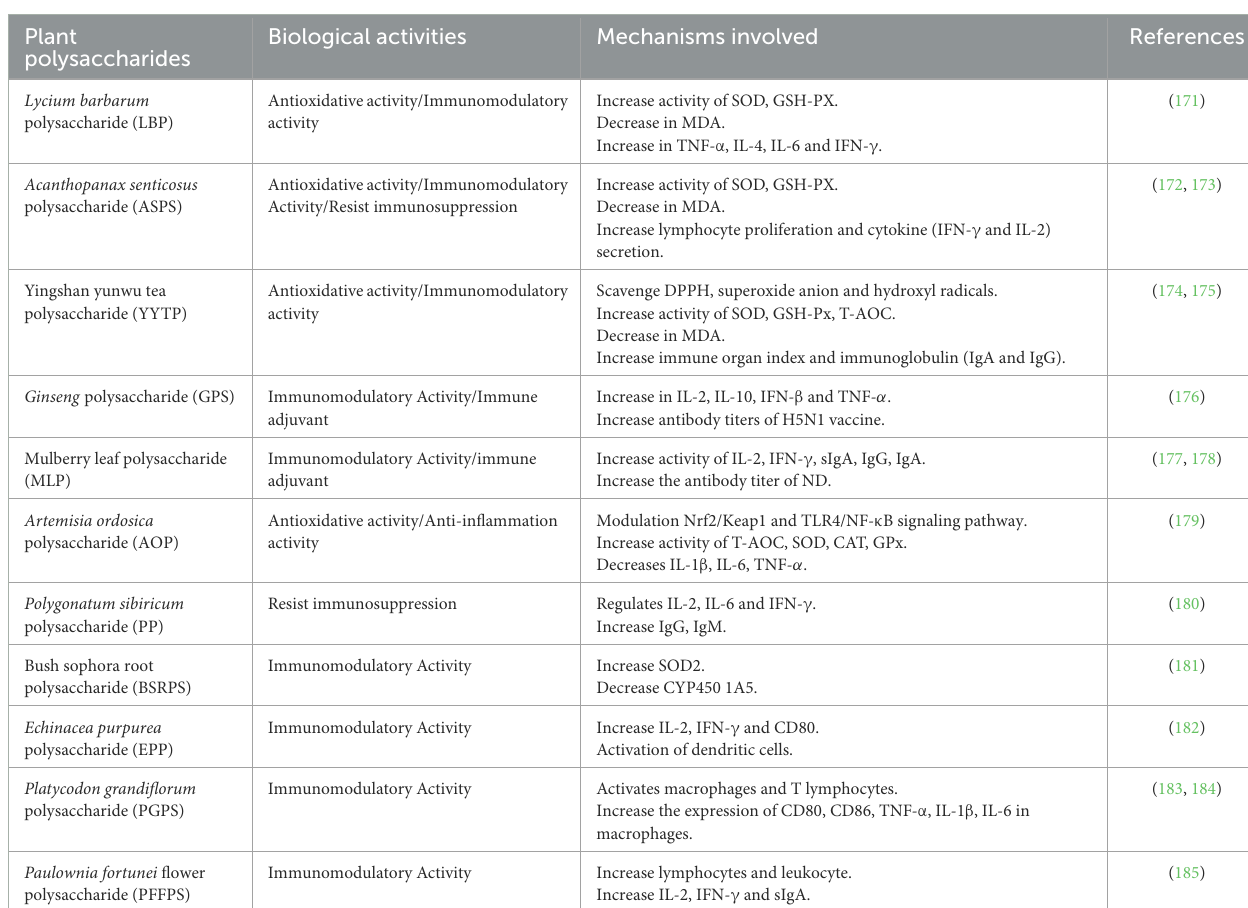
TABLE 10 Plant polysaccharide biological activity and